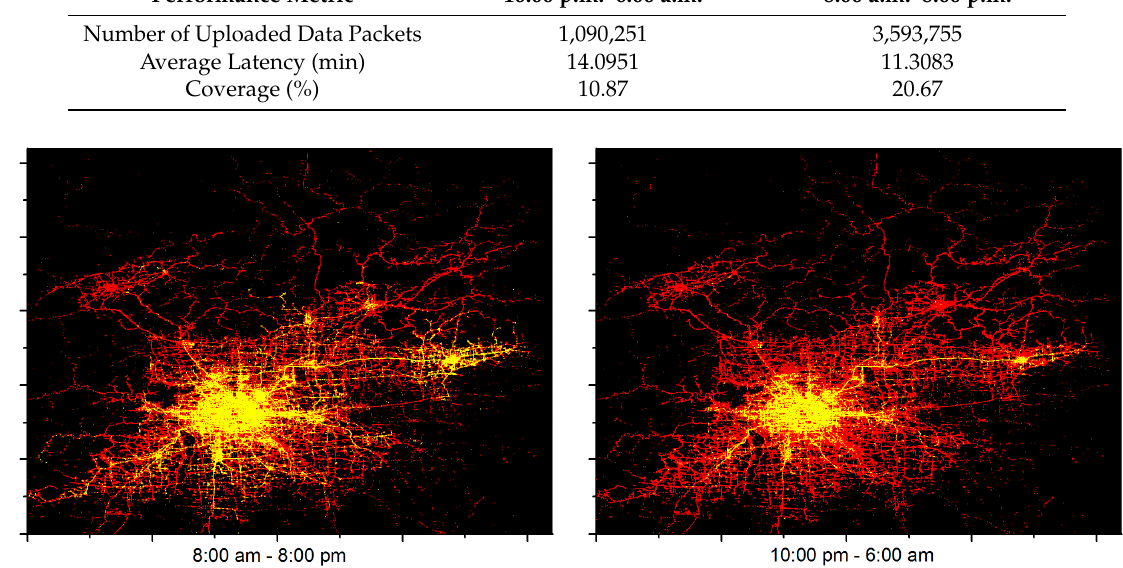
Figure 18. Distributions of covered grids at different times in a day.